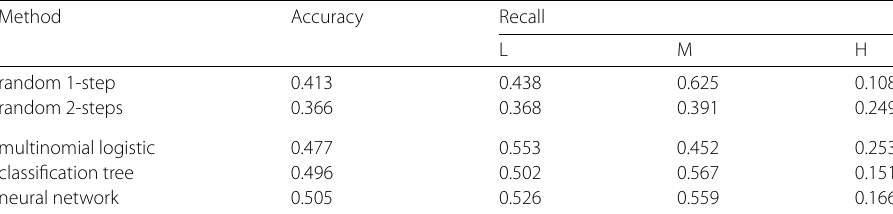
Table 2 Accuracy and recall for 2-steps classifiers. R: random, ML: multinomial logistic, CT: classification tree, NN: neural